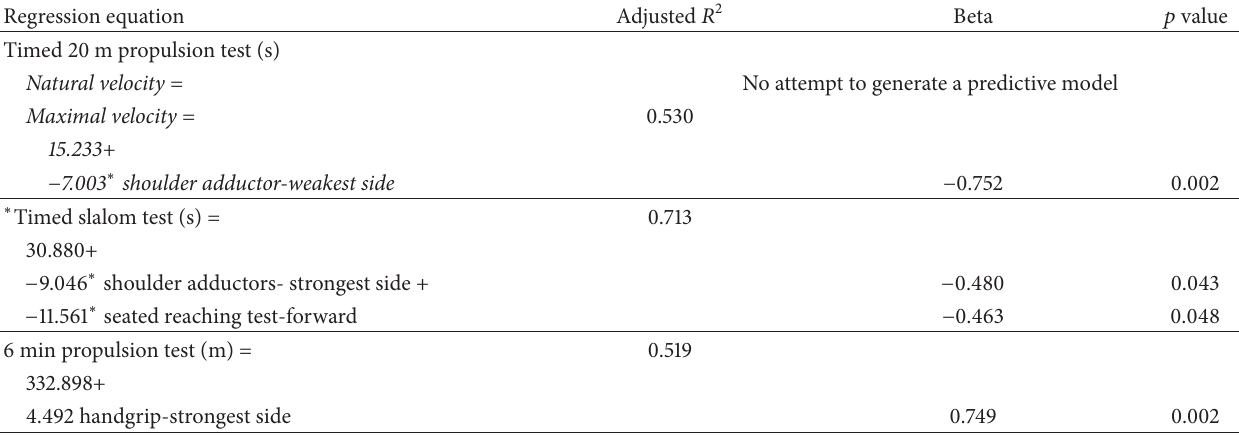
Table 4: Key predictors of the performance-based timed manual wheelchair